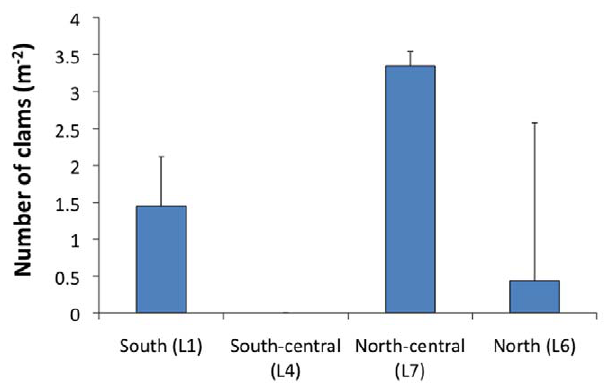
Figure 4. Clam abundance. Number of giant clams, Tridacna maxima , at sites throughout the lagoon (mean 6 1 standard error). Sites are listed from south to north.